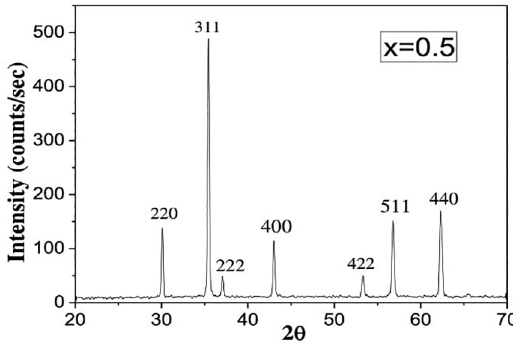
Figure 1. XRD pattern of sample